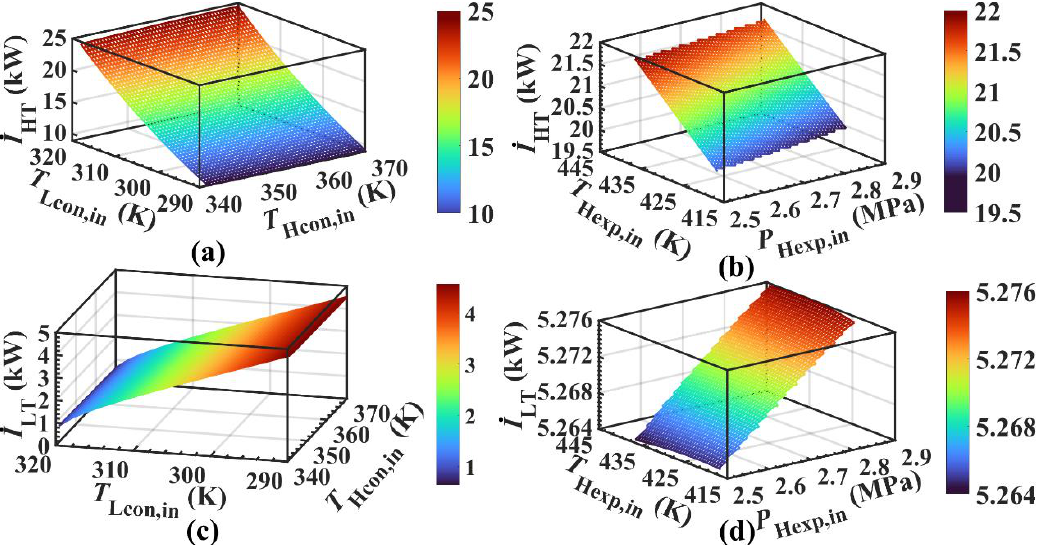
Figure 15. Influence characteristics of key variables on exergy destruction of HT cycle and LT cycle.